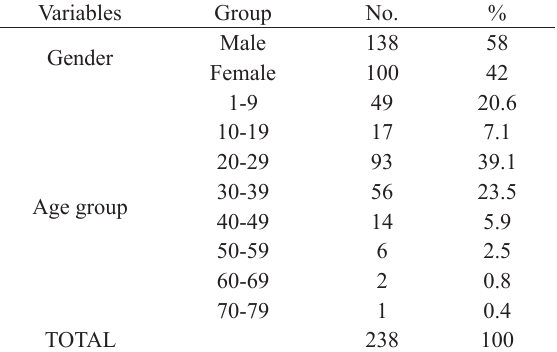
Age- and gender-based distribution of patients with acute